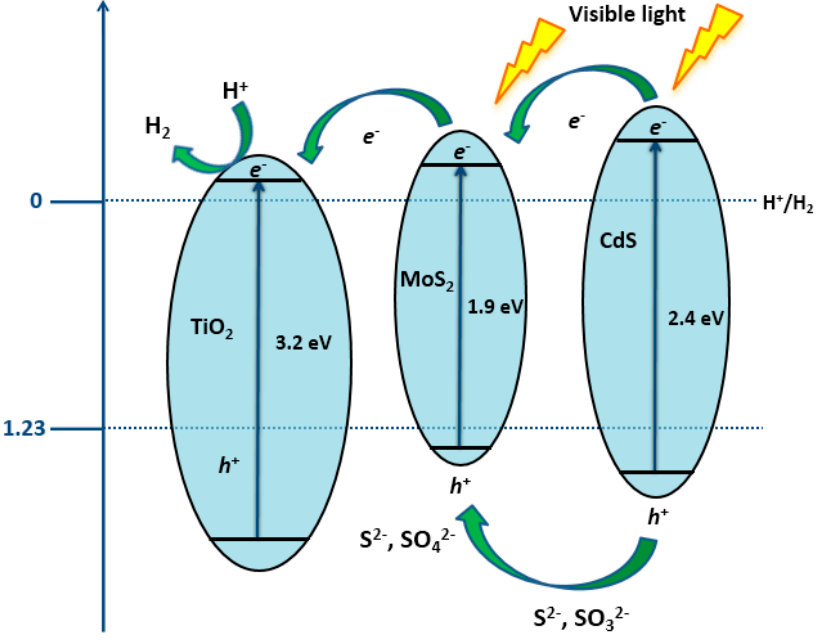
Figure 15. The proposed photocatalytic mechanism in MoS 2 -CdS-TiO 2 photocatalyst.